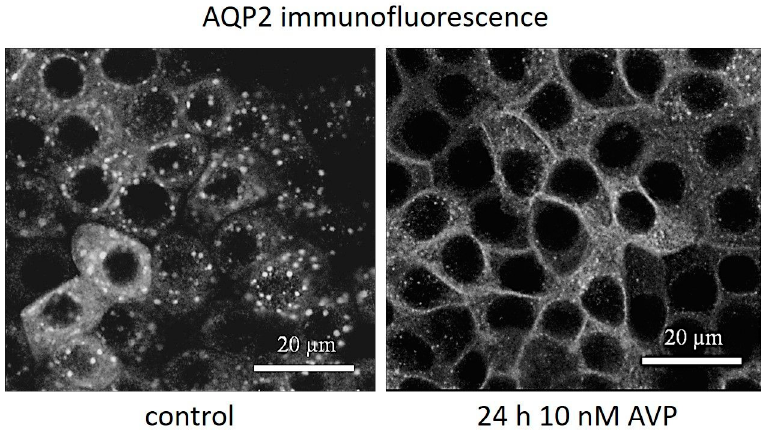
Figure 2. Effect of antidiuretic hormone (AVP) on subcellular AQP2 localization in 300-IMCD. AVP stimulation induced AQP2 insertion into the plasma membrane.